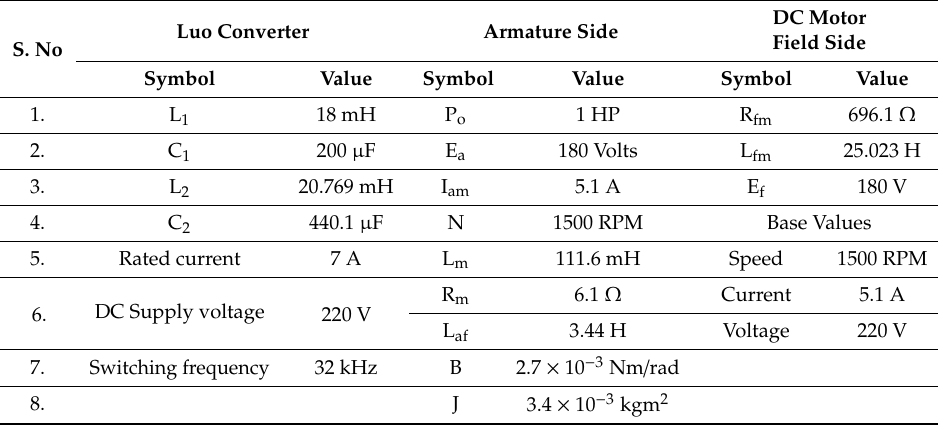
Table 4. Specifications for ETEDPOF control of a luo converter with dynamic